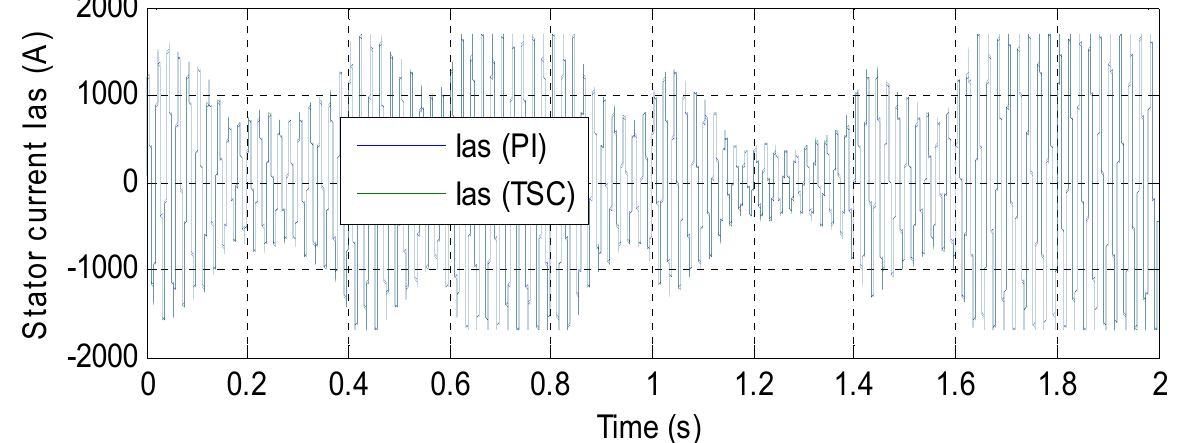
Figure 10. Torque. Figure 10. Torque.